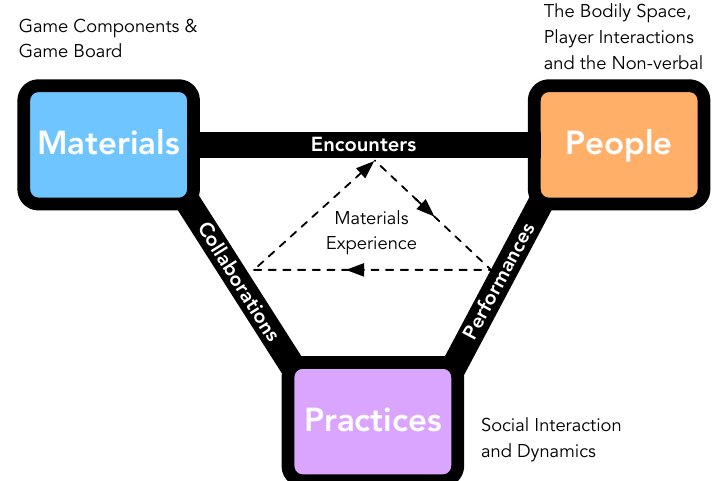
Figure 1. An illustration of the materials experience framework [6] applied to the core traits and characteristics of boardgames: the three domains materials, people , and practices are connected by specific relationships (i.e., collaborations, encounters , and performances ), which together create the inherent materials